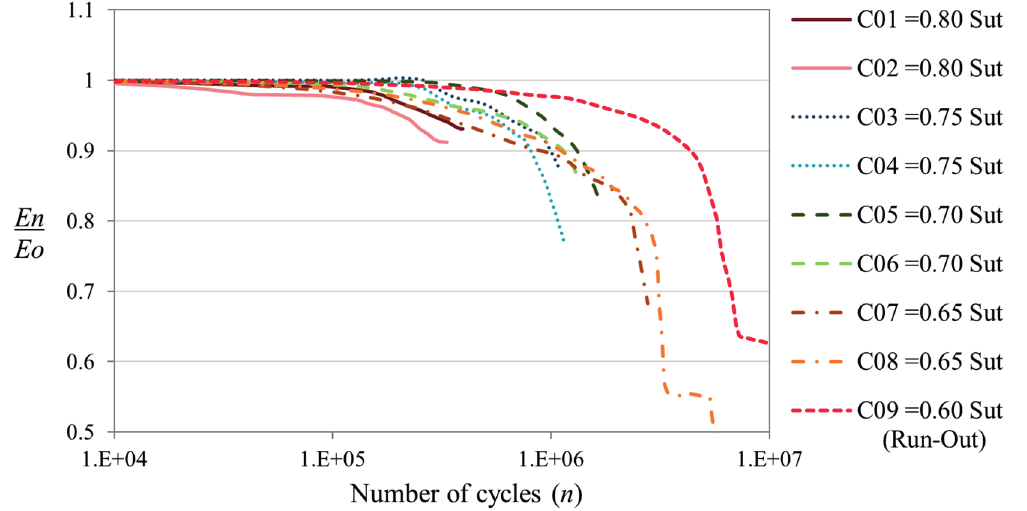
Figure 6. Stiffness degradation in semi-log graphic, for the coupons cycled with the FALSTAFF load sequence at different levels of maximum peak